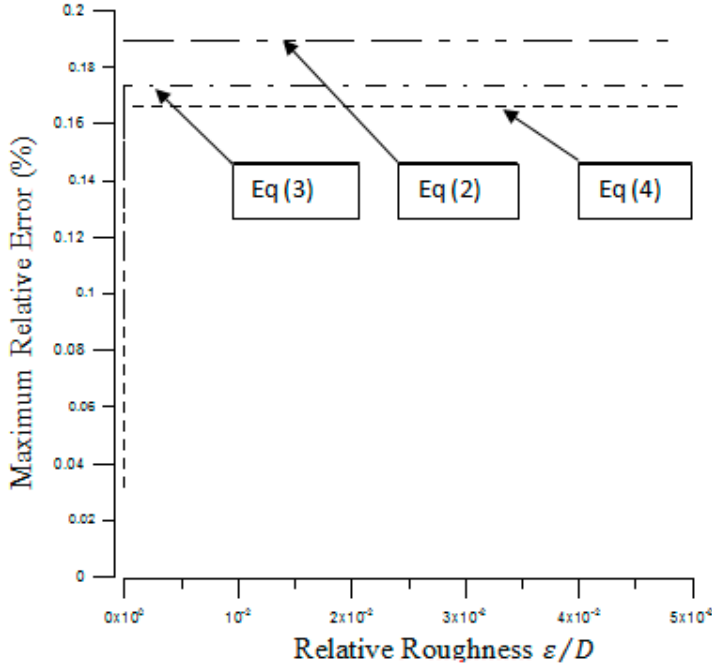
Figure 1. The maximum deviation (in percent) for versus different relative roughness. Values of Equations: 2, 3 and 4 (A1–A3) using B of Equation (2).